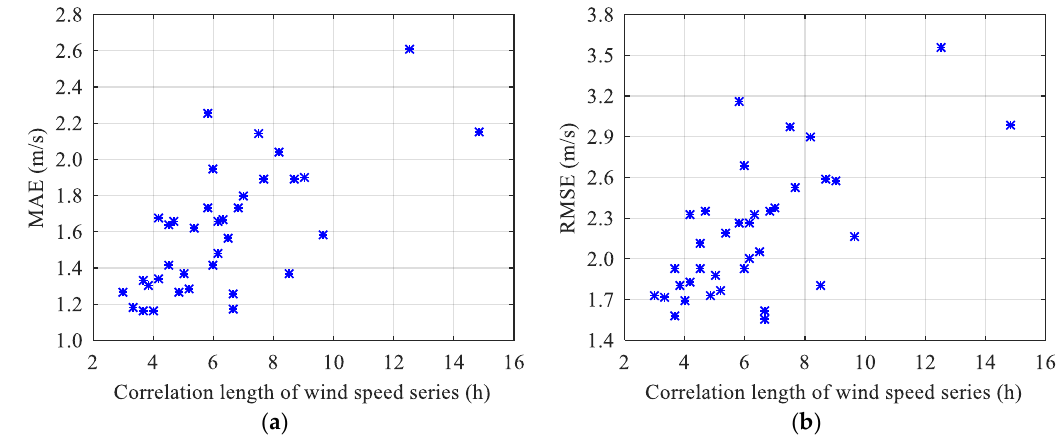
Figure 5. The variety law of MAE and RMSE with correlation length: ( a ) MAE ; ( b ) RMSE .